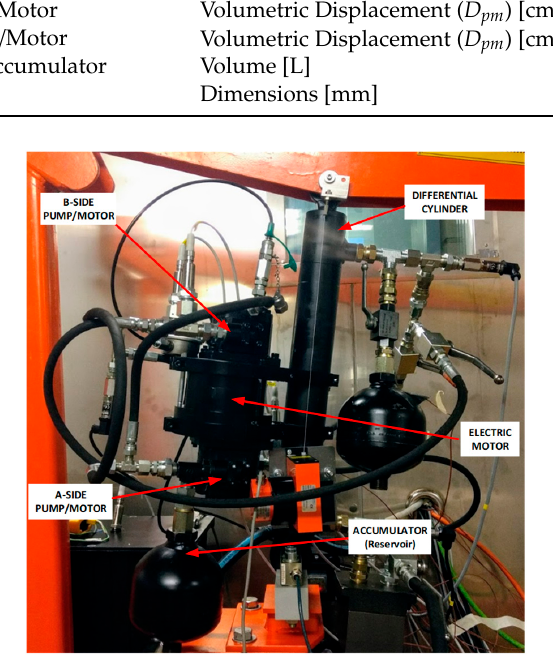
Figure 2. Test setup installed in the crane (arrows and text indicate utilized components for this study).